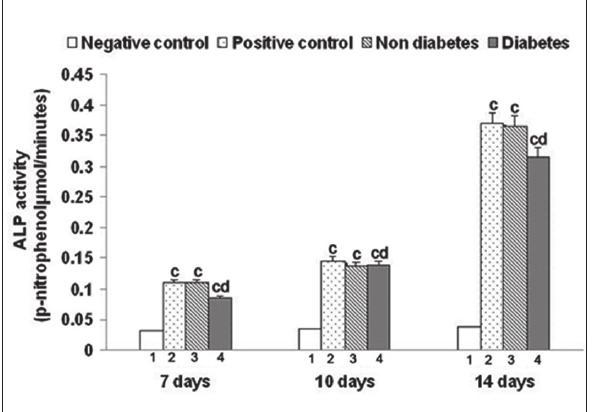
Fig. 4. Alkaline phosphatase activity in HUMSC co-cultured with osteoblasts. ALP activity was determined on day 7, 10 and 14. 1: Negative control group; 2: Positive control group; 3: Non- diabetic group; 4: Diabetic group; c P <0.01 vs. negative control group d P >0.05 vs. non-diabetic